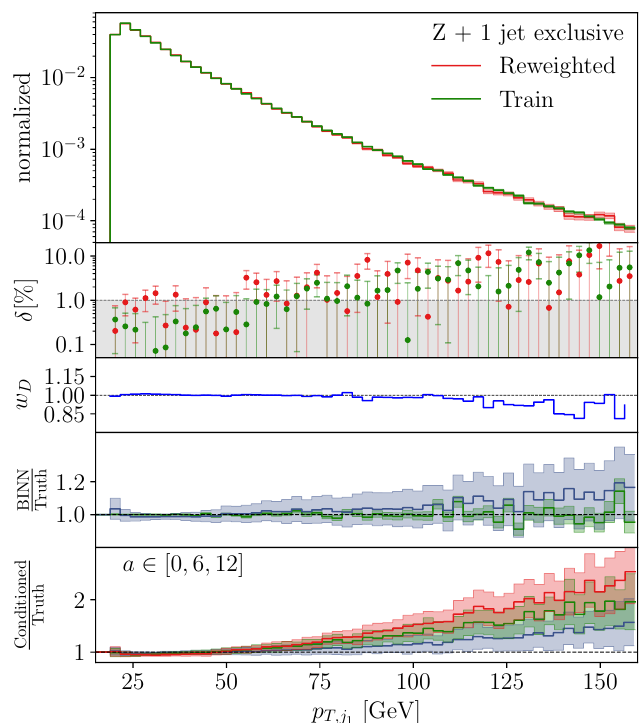
Figure 14: Illustration of uncertainty-controlled DiscFlow simulation. We show the reweighted p -distribution for the inclusive Z + jets sample, combined with the dis- T , j 1 criminator D , the BINN uncertainty, and the sampled systematic uncertainty defined through the data augmentation of